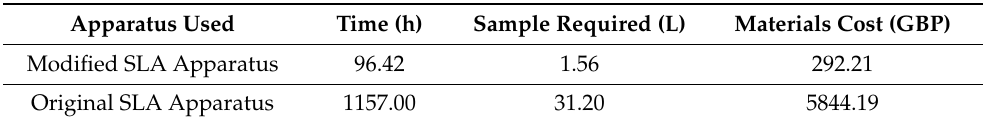
Table 2. Cost-effectiveness comparison of the two SLA apparatus used to screen 156 pharmaceutical photopolymer